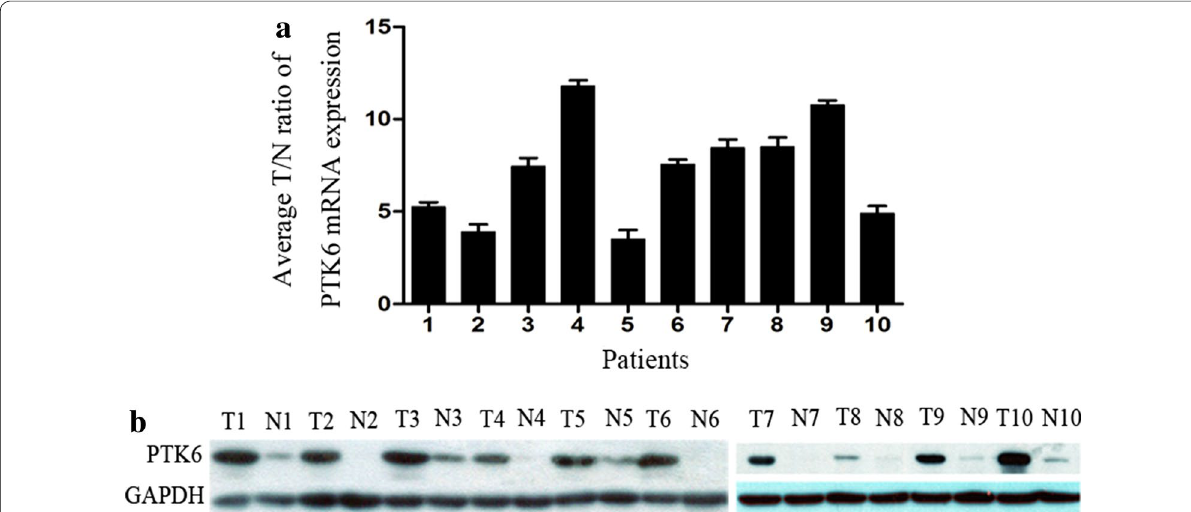
Fig. 1 Quantitative reverse transcription‑polymerase chain reaction (qRT‑PCR) and western blotting analysis of protein tyrosine kinase 6 (PTK6) expression in early‑stage cervical squamous cell cancer tissues. a qRT‑PCR analysis of PTK6 mRNA expression in early‑stage cervical squamous cell cancer tissues. The mRNA level of PTK6 in cancer tissues (T) is higher than that in paired adjacent non‑tumorous cervical tissues (N), and the range of fold increase (average T/N ratio) was 3.6–11.9. b Western blotting analysis of PTK6 protein expression in early‑stage cervical squamous cell cancer tissues. The protein level of PTK6 in 10 cervical squamous cell cancer tissues (T) was higher than that in paired adjacent non‑tumorous cervical tis‑ sues (N). Glyceraldehyde‑3‑phosphate dehydrogenase (GAPDH) was used as the loading